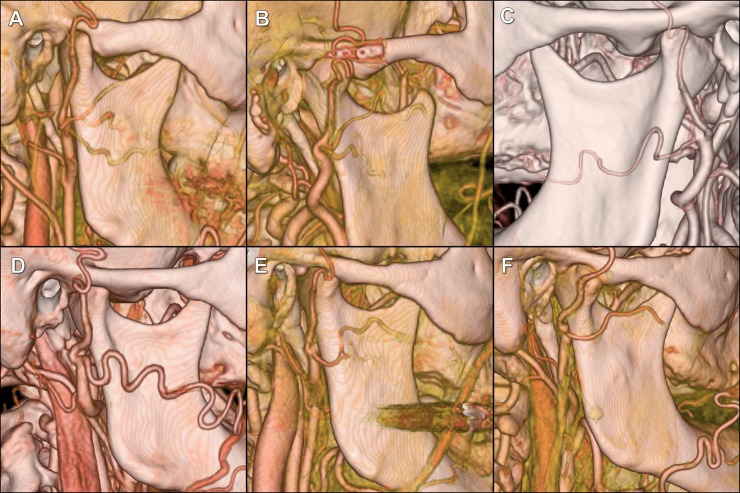
The CTAs of the external carotid artery with 3D volume-rendering showing variations of the transverse facial artery (TFA).Black arrows indicate TFA.(A) Double TFA, upper TFA is divided into another two branches. (B) Double TFA. (C) TFA branches off from the maxillary artery. (D) Three arteries arising from the same point: superficial temporal artery, maxillary artery and TFA. The latter is dominating over the facial artery, which was hypoplastic. (E and F) Three arteries arising from the same point: superficial temporal artery, maxillary artery and TFA.